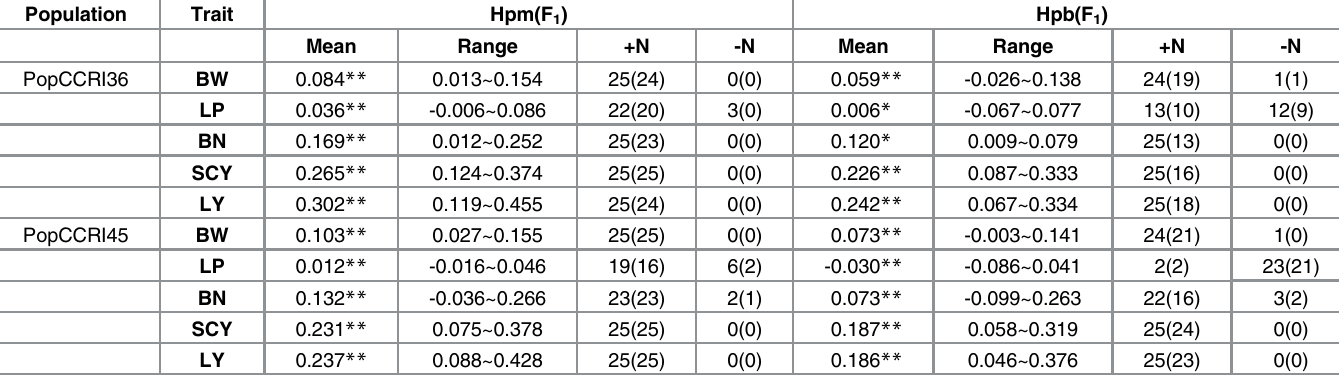
Table 6. Mid-parent population mean heterosis and surpassing parental heterosis of yield and yield components. Population